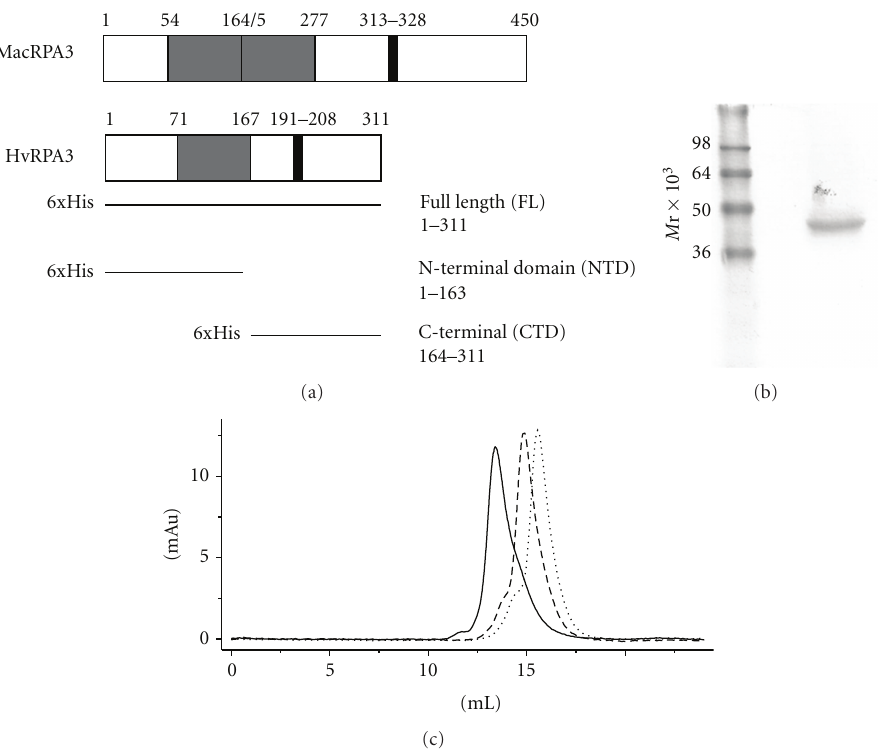
Figure 1: (a) Schematic representation of the arrangement of OB-folds (light grey) and CCCH zinc fingers (dark grey) and respective amino acid positions in HvRPA3 and MacRPA3 [10]. Constructs used in this study are indicated. (b) SDS-PAGE analysis of 2.5 μ g purified full length HvRPA3. The 6xHis-tagged construct has a predicted MW of 35 . 4 × 10 3 . (c) Size exclusion profiles of HvRPA3 in 0.2 M (solid line), 1M (dashed line), and 3M (dotted line) KCl. The x axis shows elution volume (mLs) and the y axis absorbance at 280 nm.